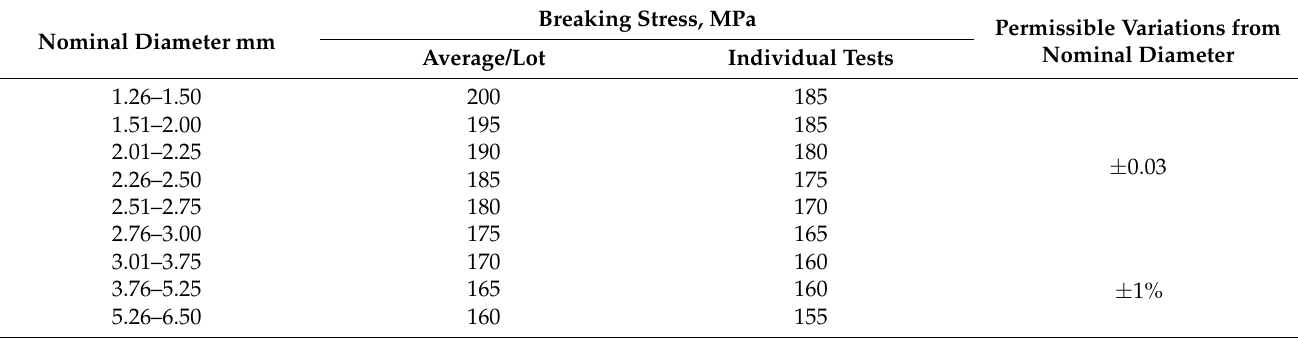
Table 2. Breaking tensile stress and diameter tolerance of aluminum wires. Breaking Stress, MPa Permissible Variations from Nominal Diameter mm